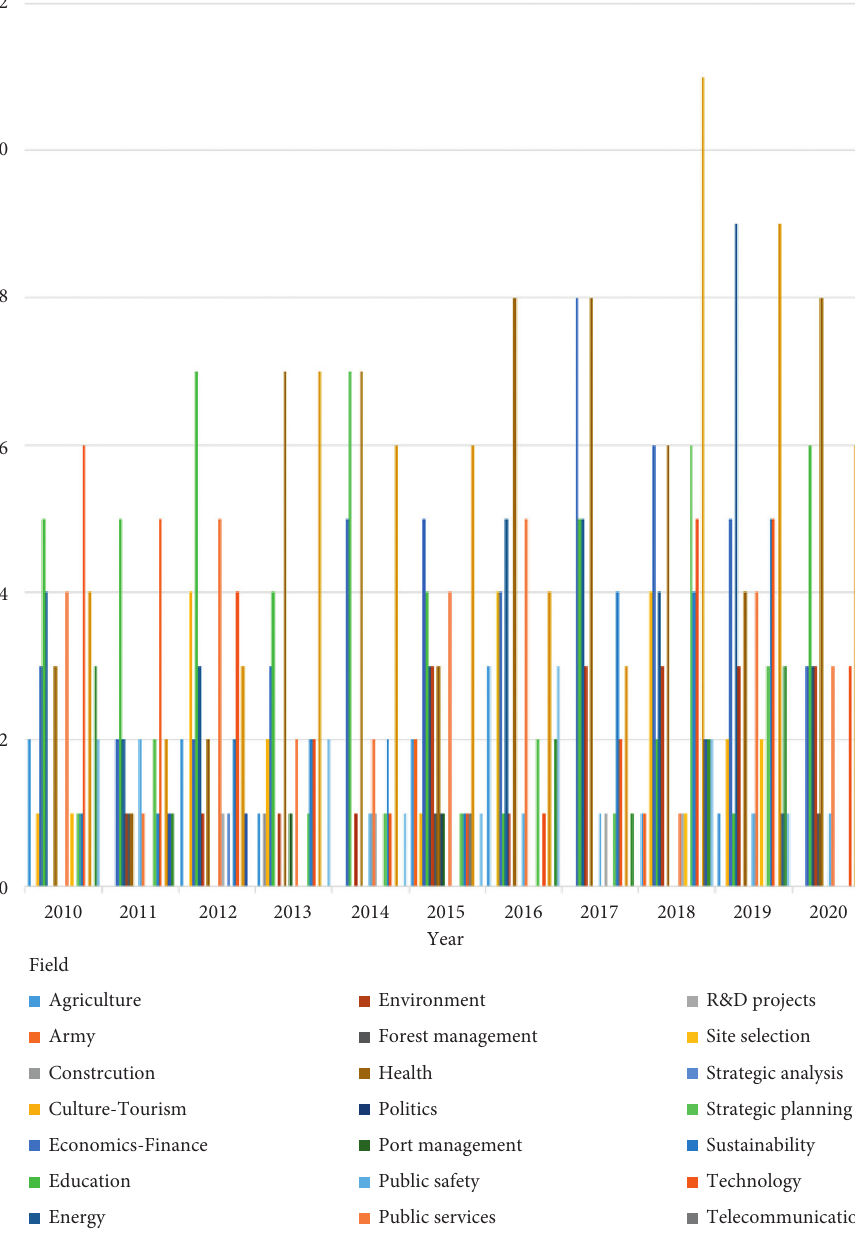
Figure 11: Crosstabulation by research field and